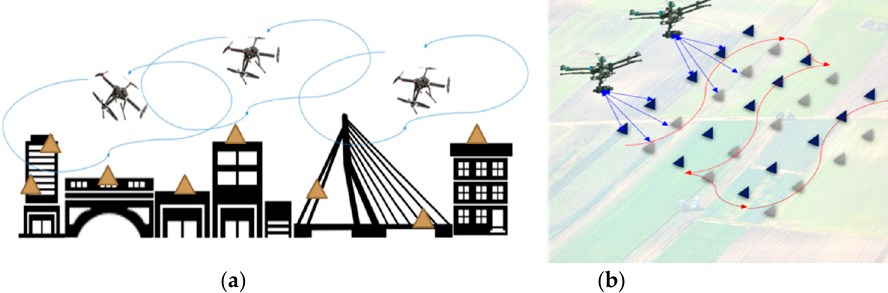
Figure 1. Conceptual illustrations of the proposed aerial–ground wireless sensing network (AG-WSN) for field monitoring: ( a ) complex 3D field in an urban setting and ( b ) largely 2D terrain field in an agriculture setting.